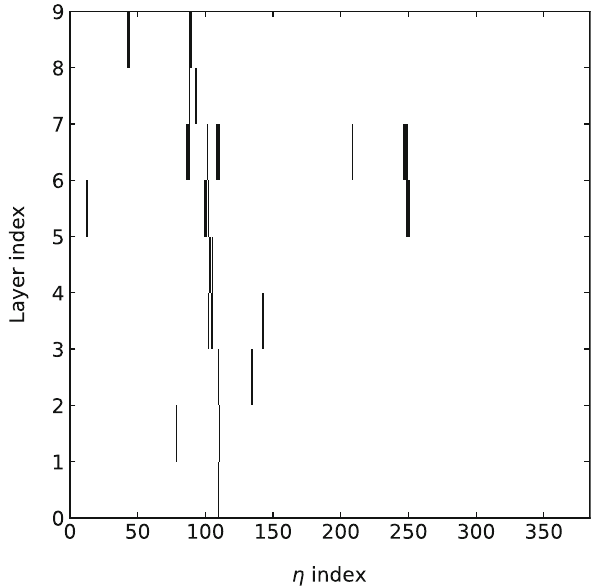
Fig. 1 Example of RPC event image used to train the CNN: an event with one low- p T muon ( p T (cid:2) 6 GeV, η (cid:2) 0 . 3 , η index (cid:2) 110) plus background noise due to pileup and cavern background. The image shows the complete 9 × 384 strips toy detector; each row corresponds to one of the nine RPC layers, while the η index is a rescale of the